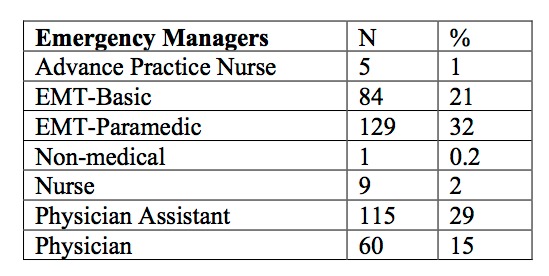

Table 2. Self reported medical occupations of respondents, all of who worked in emergency management areas. (N=403)